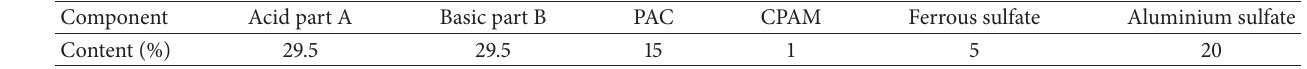
Table 6: The optimized compositions of BTA.